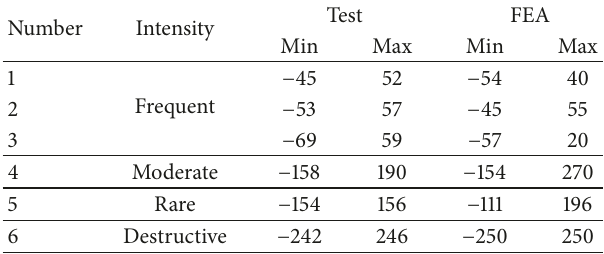
Table 6: Strain response results for foundation slab (in 𝜇𝜀